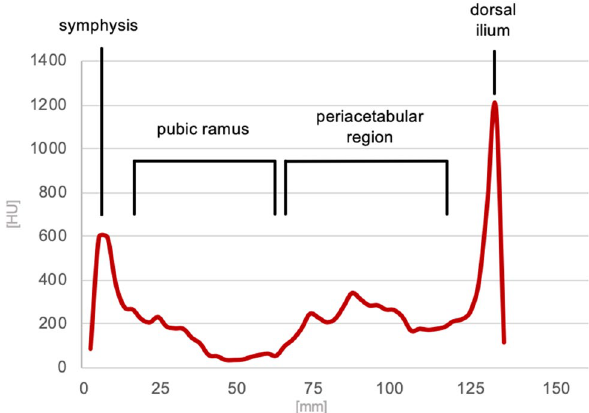
Figure 3. Mean local grey value distribution measured along the screw corridor showing a first cortical peak at the entry point, lower HU in the superior pubic ramus, slightly higher grey values in the periacetabular trabecular bone and a strong second cortical peak finally passing the cortex of the lateral